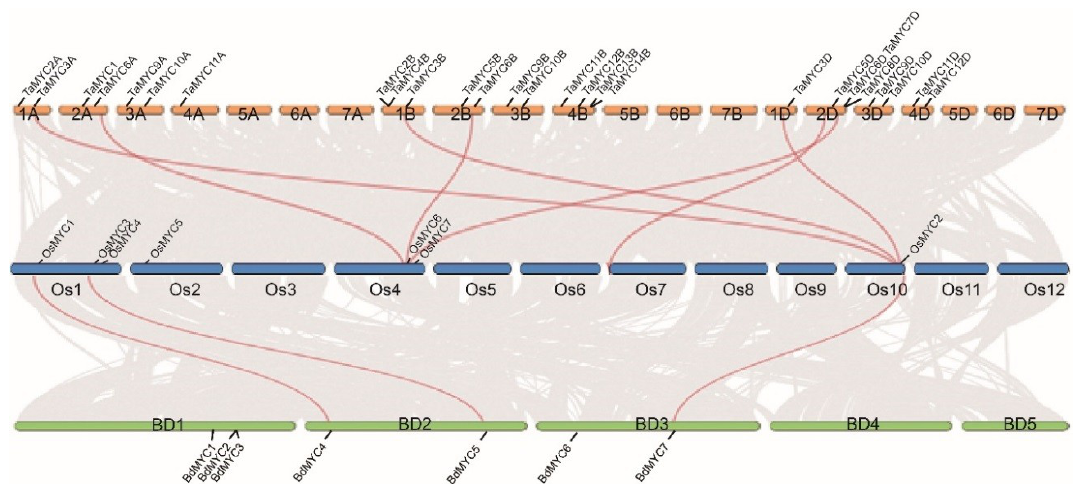
Figure 1. Chromosome location, homologous gene pairs of TaMYC , OsMYC , and BdMYC genes. Gray lines in the background indicate the collinear blocks within wheat, rice, and B. distachyon genomes, while the red lines highlight the homologous gene pairs.